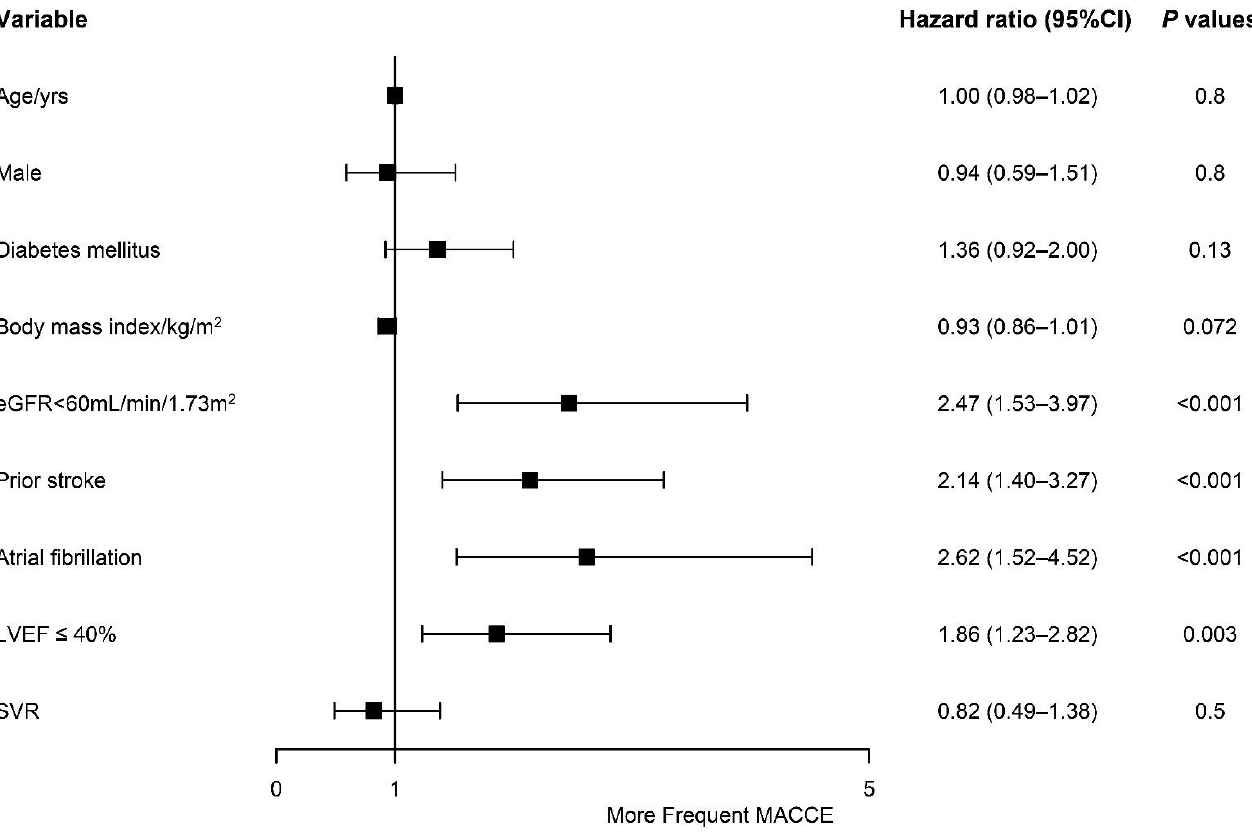
Figure 4. Association between baseline characters and the risk of major adverse cardiac and cerebrovascular events according to a multivariable analysis. CI = confidence interval. eGFR = estimated glomerular filtration rate. LVEF = left ventricular ejection fraction. SVR = Surgical ventricular reconstruction.